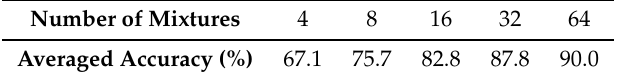
Table A2. Averaged accuracy values of the GMM classifier considering a 2 n sweep from 4 to 64